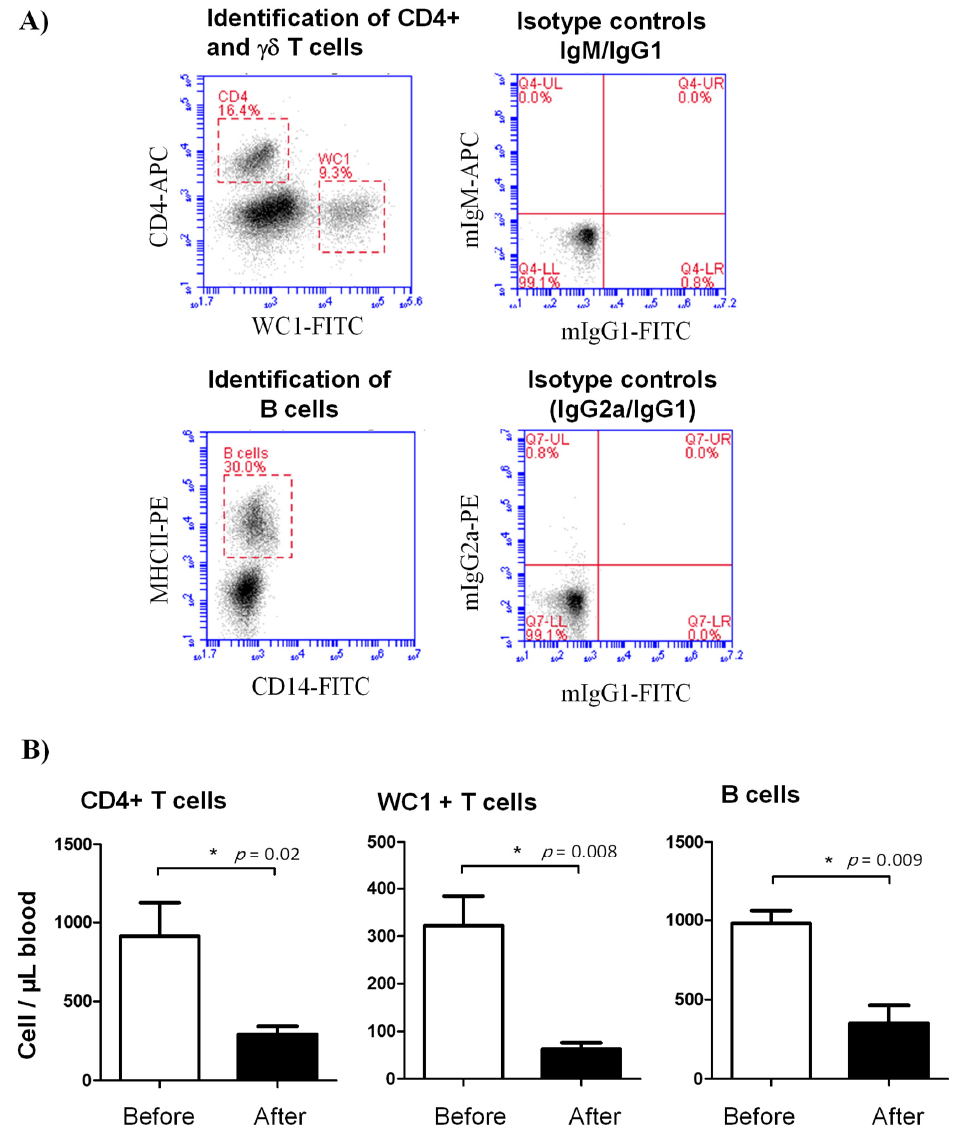
Figure 2. Lymphocyte composition in the blood of lornoxicam-treated animals. ( A ) Flow cytometric gating strategy for the identification of selected lymphocyte subsets in camel blood. After gating on lymphocytes within the mononuclear cell population in a SSC-A/FSC-A dot plot, CD4+ T cells and γδ T cells were identified based on their single-staining with CD4 and WC-1, respectively. In a CD14 against MHC-II dot plot, camel B cells were identified as MHC-II+CD14- cells. The cell numbers of camel B cells, CD4+ T cells, and γδ T cells were estimated by multiplication of their percentages in blood lymphocytes with the absolute number of lymphocytes. Mean cell numbers and standard error of the mean were presented for all subsets before and after treatment. ( B ) Differences between the means were considered significant (*) if p < 0.05 .